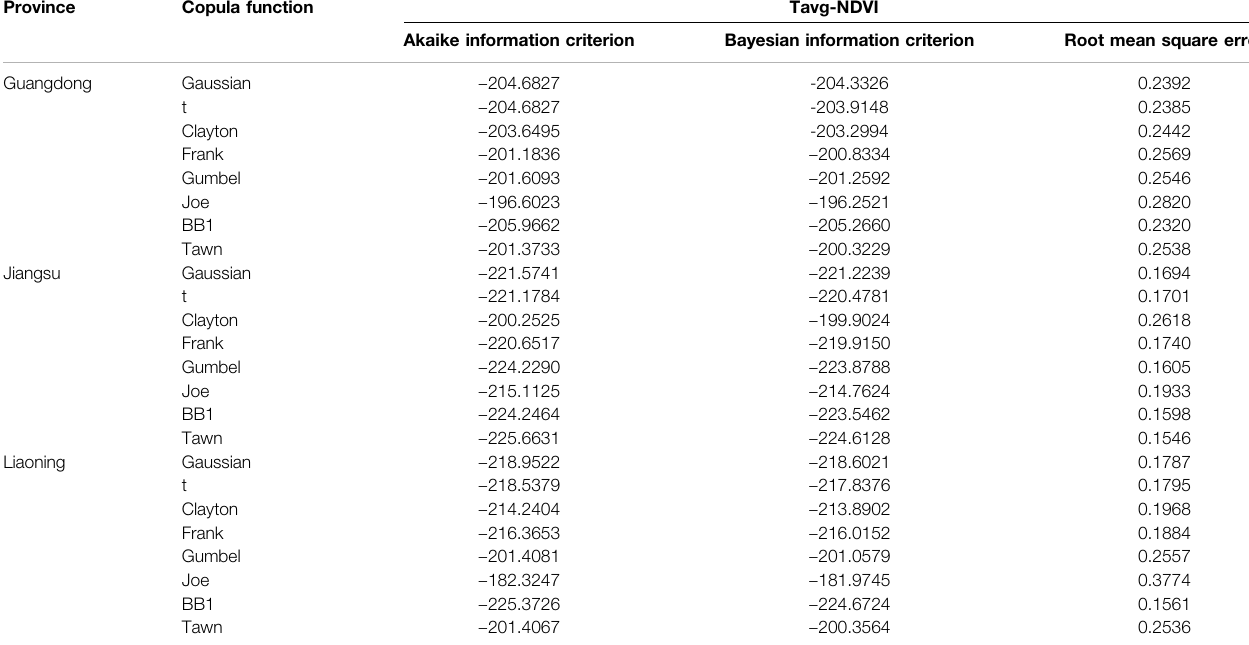
TABLE 3 | Copula function cluster selection criteria for mean temperature-normalized difference vegetation index (NDVI) in Guangdong, Jiangsu, and Liaoning. Province